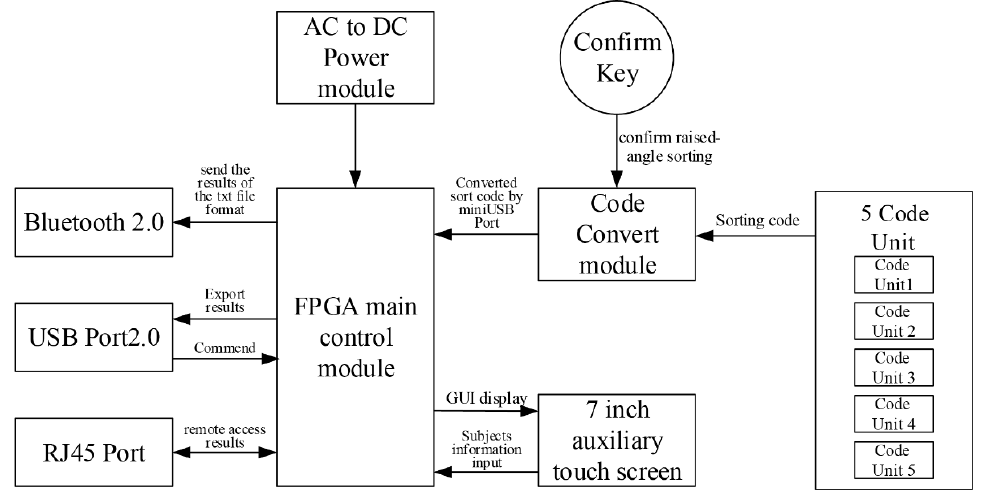
Figure 6. Schematic diagram of the structure of the haptic angle sorting system.